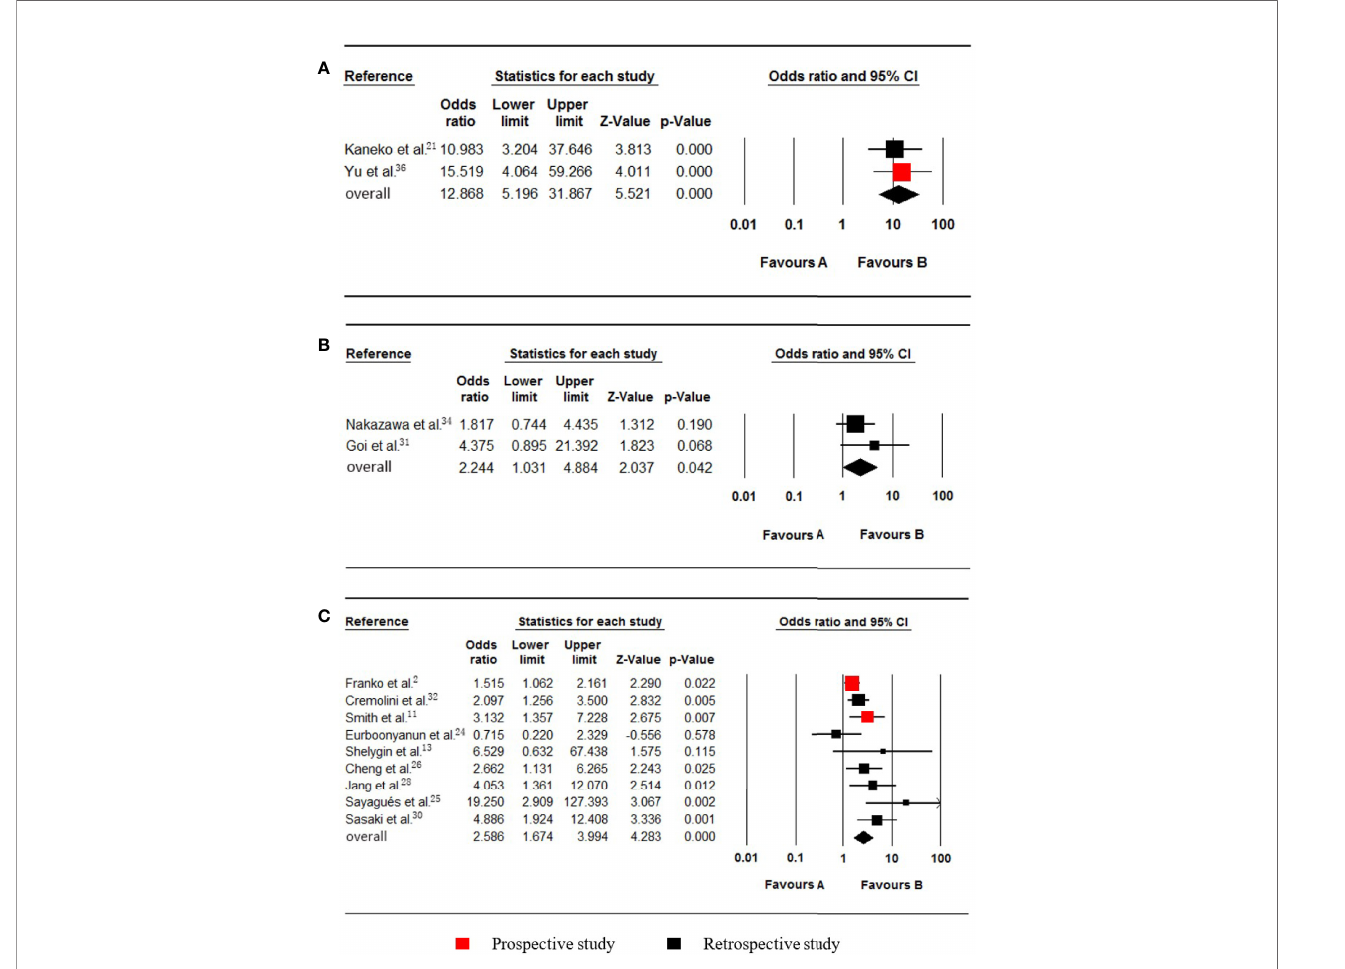
FIGURE 5 | Forest plot for serum CA19-9, PROK1/PROKR2 and BRAF. Favours A, non-pmCRC. Favours B, synchronous pmCRC. (A) serum CA19-9. (B) PROK1/PROKR2. (C)